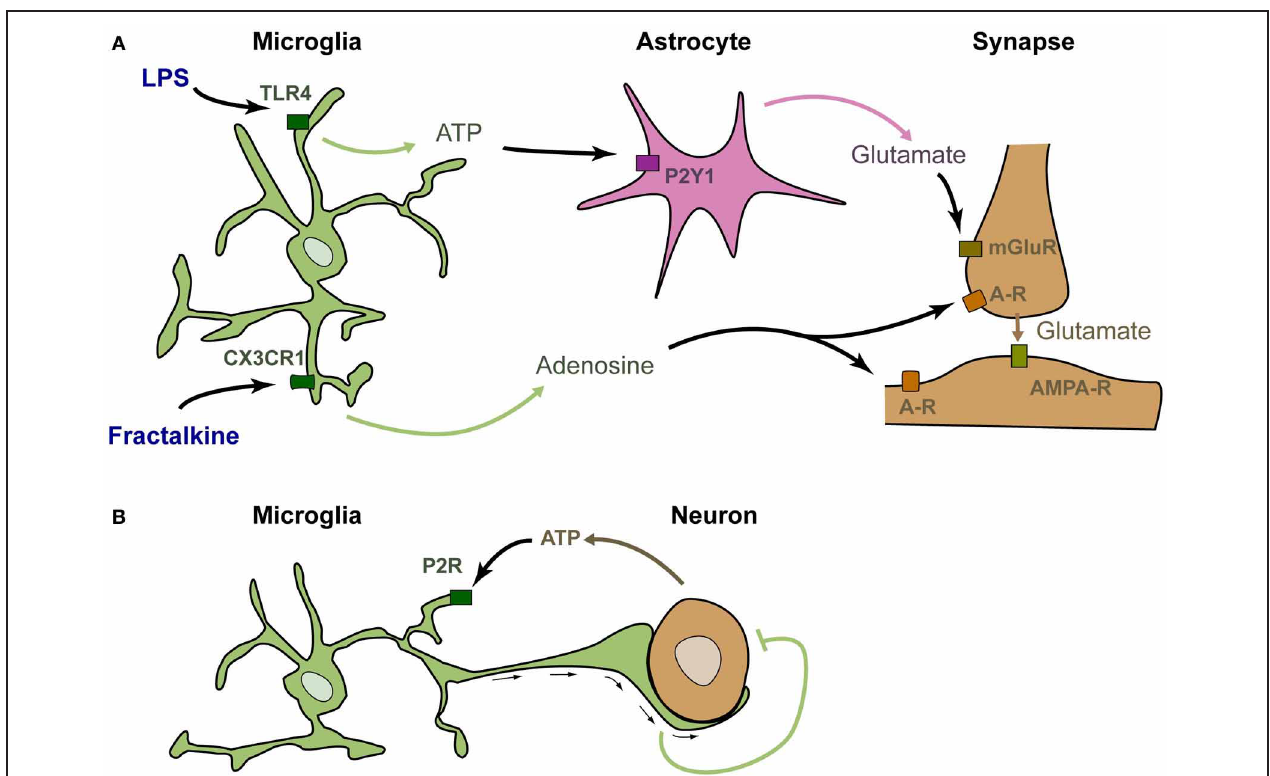
fractalkine induces the release of adenosine, which decreases neuronal activity (Meucci et al., 1998; Ragozzino et al., 2006; Piccinin et al., 2010). (B) In zebrafish larva, active neurons release the ATP that attracts microglial bulbous processes. These processes decrease neuronal activity by an as yet unknown mechanism (Li et al.,